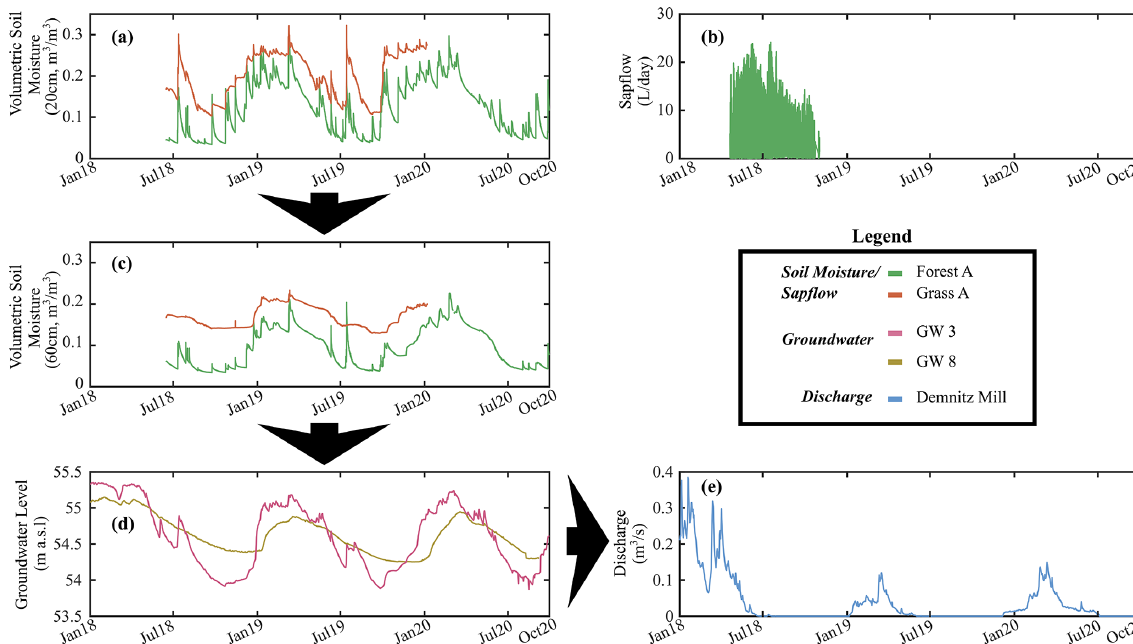
Figure 4. (a) Shallow soil moisture, (b) sap flow, (c) deep soil moisture, (d) groundwater levels from two wells, and (e) discharge from Demnitz Mill Creek station. Arrows show connections between layers and fluxes. ∗ Groundwater 3 is within the wetland and Groundwater 8 is outside the wetland (near the areas of Forest A and Grass A; see Fig.